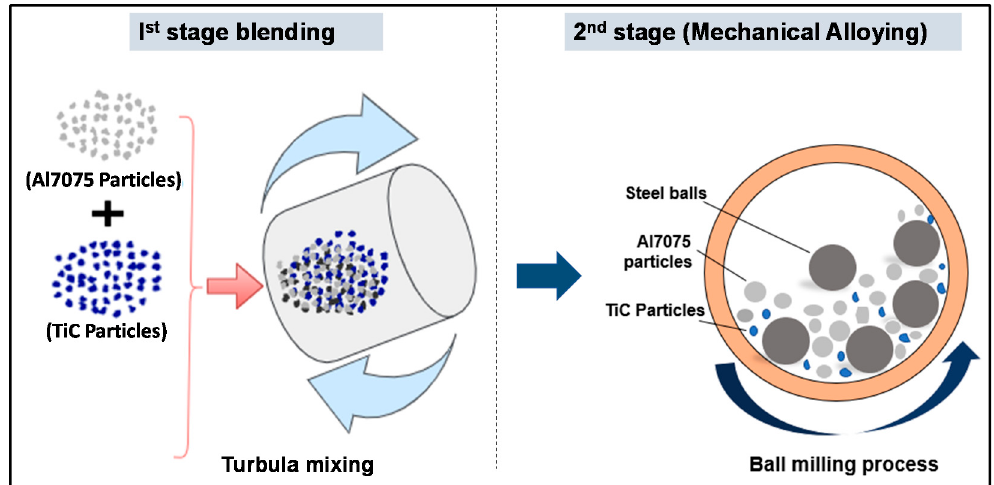
Figure 1. Schematic illustration of the novel two-stage blending process for homogeneous mixing of the matrix and reinforcement powders.